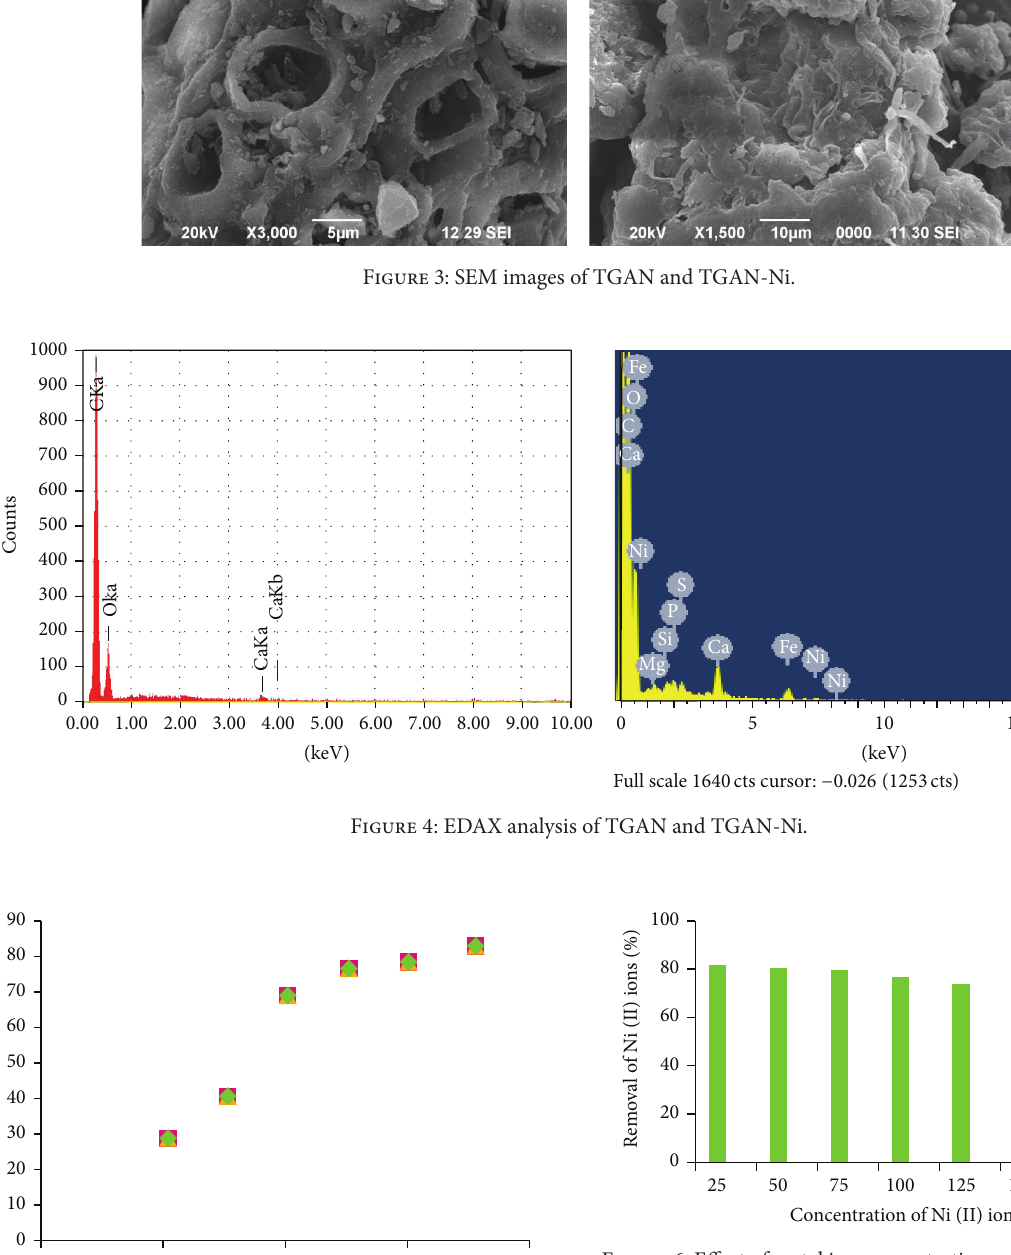
Figure 6: Effect of metal ion concentration on the adsorption of Ni (II) ions by